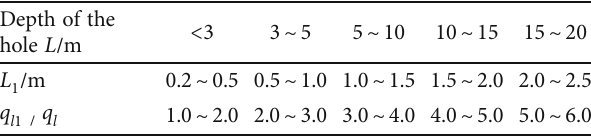
Figure 1: Digital electronic detonator and priming equipment. Table 2: Charge increase of reinforced charge section at the bottom of hole in presplitting